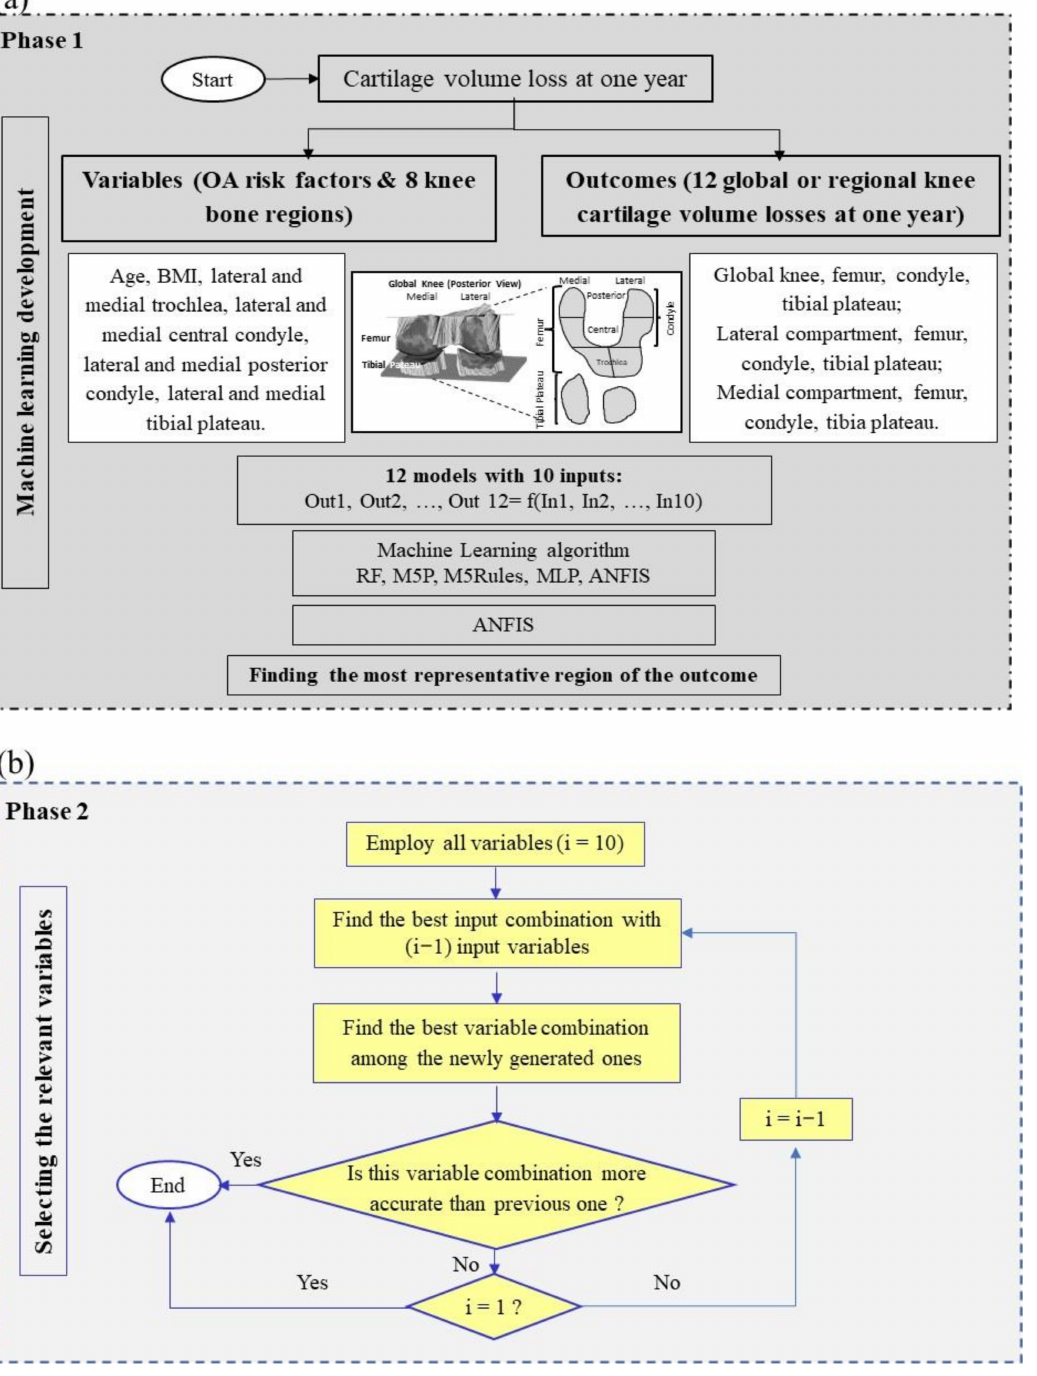
Figure 1. Applied methodology in machine learning development. The development of the prediction model was performed in two phases ( a ) Phase 1 and ( b ) Phase 2 as described. Outcome (Out)1, Out2, . . . , Out12 represent 12 global or regional knee cartilage volume losses at one year; In1, In2, . . . , In10 represent two OA risk factors and eight knee bone curvature regions. BMI, body mass index; RF, random forest; M5P, M5 prime; MLP, multilayer perceptron; ANFIS, adaptive neuro-fuzzy inference